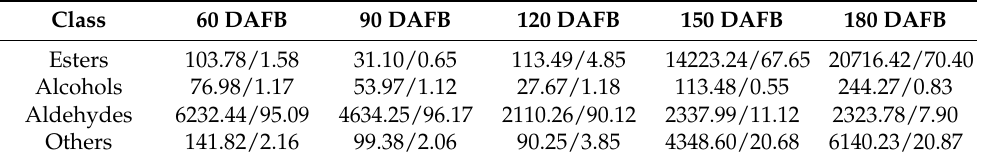
Table 4. Total content ( µ g/kg) and percentage (%) of each type of volatiles in ‘Orin’ apple peels at different ripening stages.